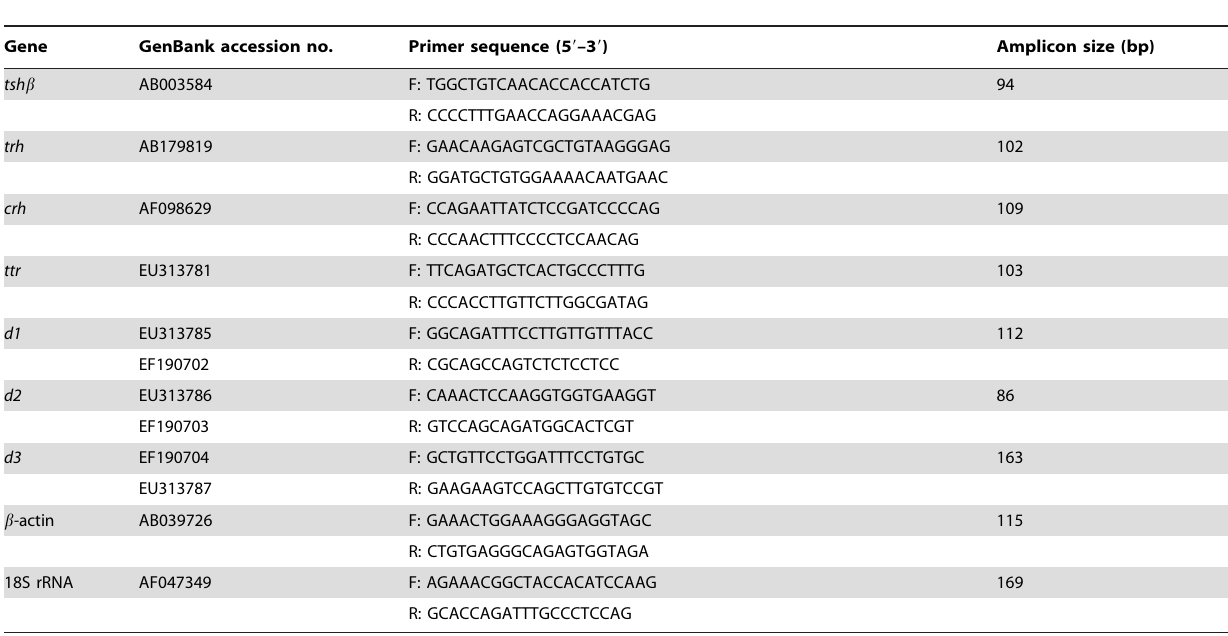
Table 1. Nucleotide sequences of the primers used for real-time polymerase chain reaction and product sizes.